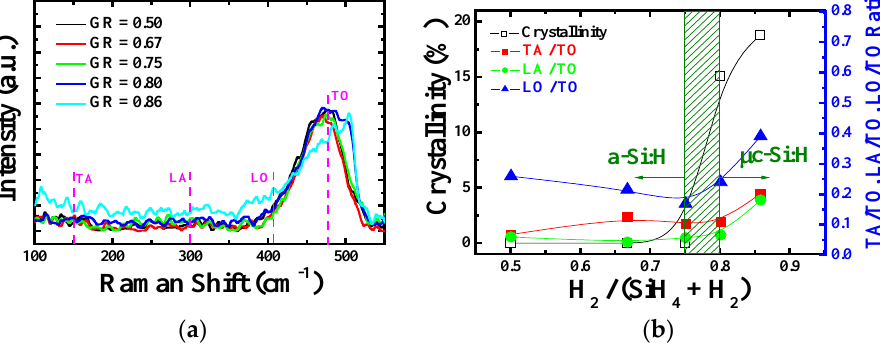
Figure 1. ( a ) The Raman spectroscopy of passivation layers as a function of gas ratio (GR) ( b ) The dependence of the Raman characteristic parameters and crystallinity on GR.